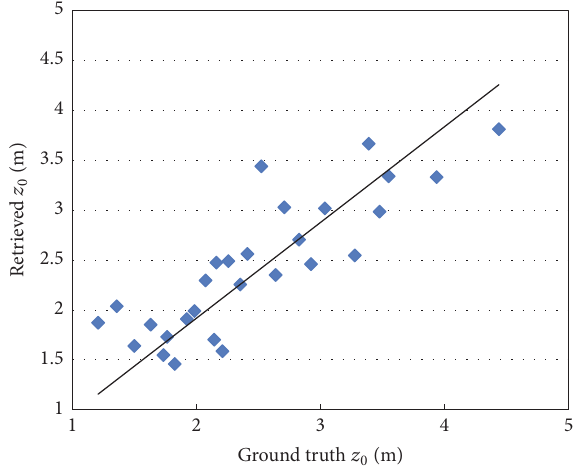
Figure 10: Validation of the retrieved 𝑧 0 using the remaining 28 pairs of